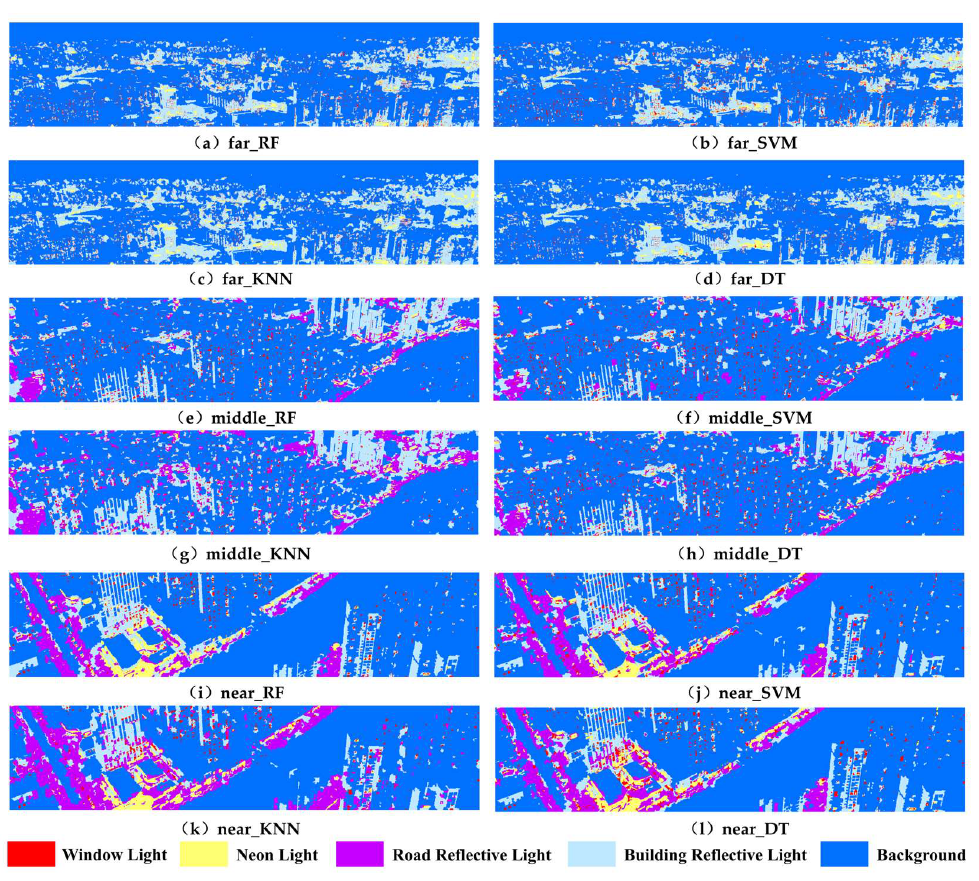
Table 5. Far view region classification accuracy table (%).